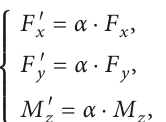
Figure 8: Correction factors F relative curvature